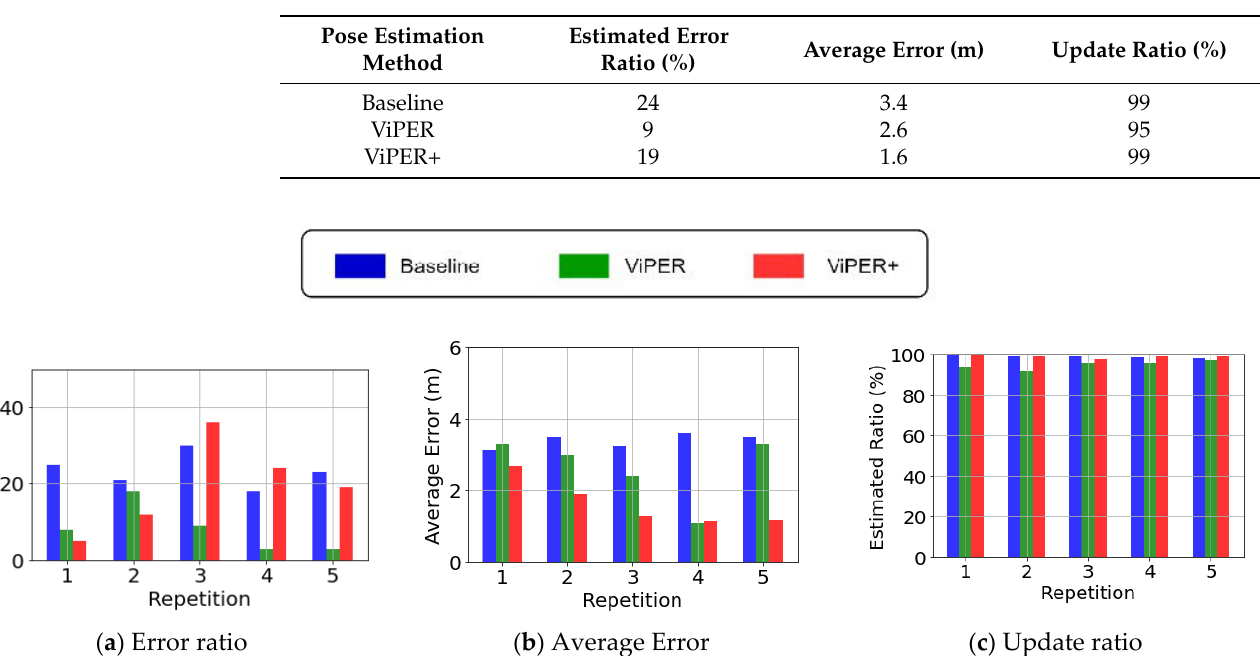
Table 4. Pose estimation result for NLOS scenario. ViPER+ provided the same update rate as the baseline method while reducing the error rate and average error compared to the baseline.